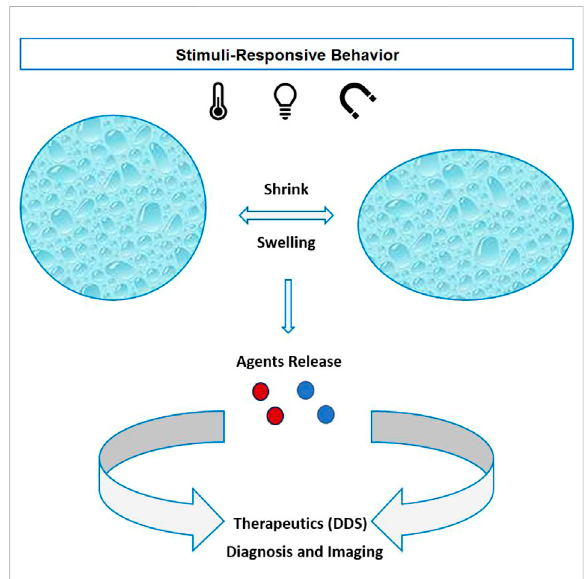
FIGURE 3 Physical stimuli-responsive nanohydrogels with shrink/ swelling behavior and active agents released for therapeutics or diagnostic